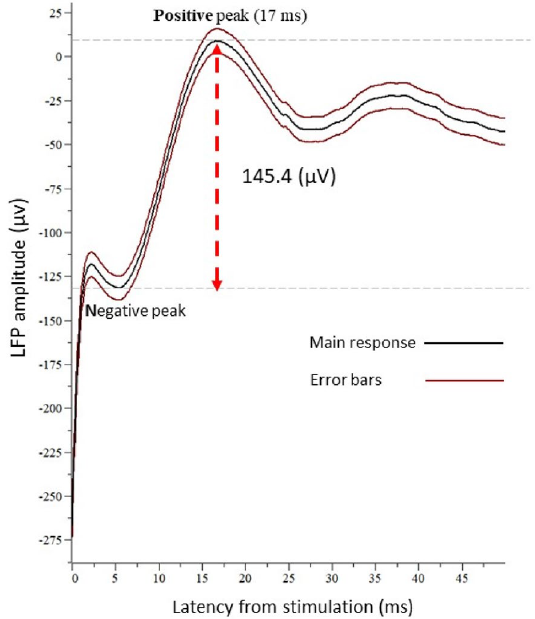
Figure 1. Evoked triphasic LFP response after electrical stimulation of the round window. The LFP recording was configured so that it was triggered by the last pulse of the stimulation for all 50 trains of stimulation. The trace represents an average of 50 sweeps ± 1 SE.